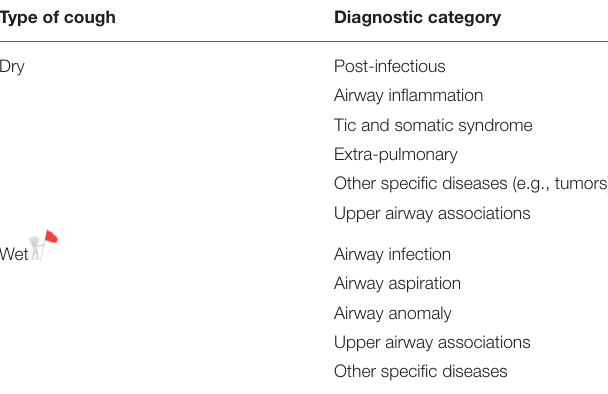
TABLE 6 | Type of cough and potential diagnostic